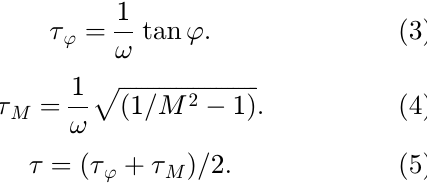
ffiffiffiffiffiffiffiffiffiffiffiffiffiffiffiffiffiffiffiffiffiffiffiffiffi p ð 1 = M 2 (cid:1) 1 Þ